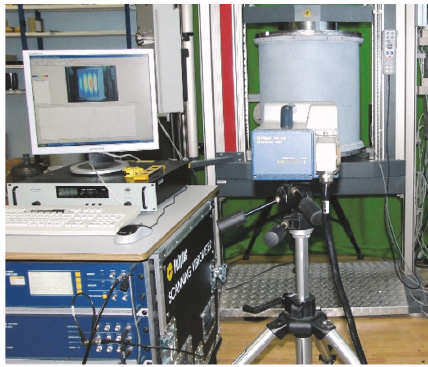
Figure 7: Experimental set-up for vibration tests.